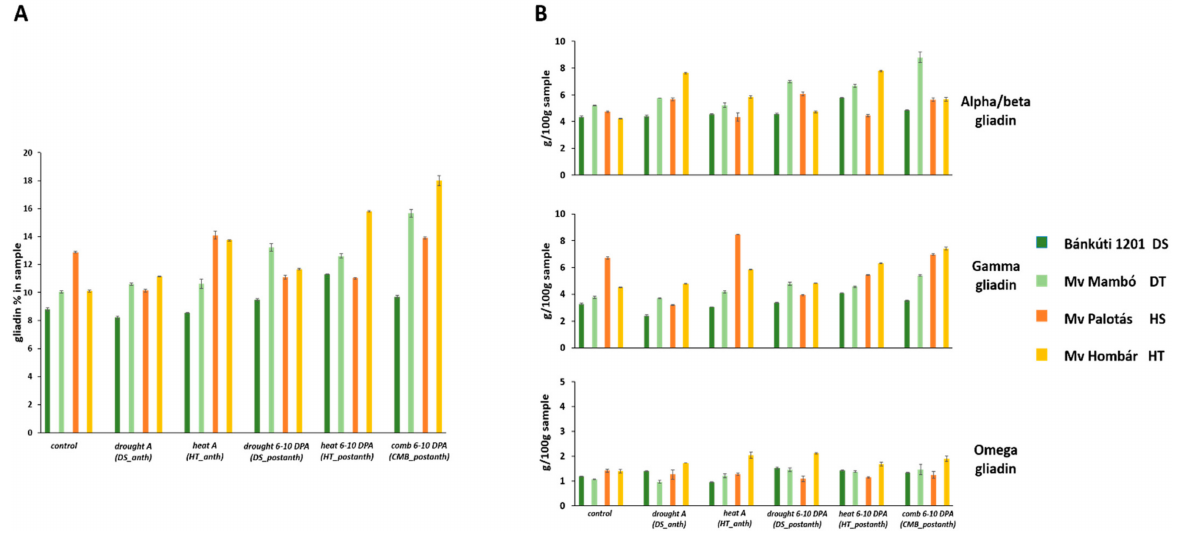
Figure 1. Gliadin content ( A ) and composition ( B ) of samples altered by different abiotic treatments.